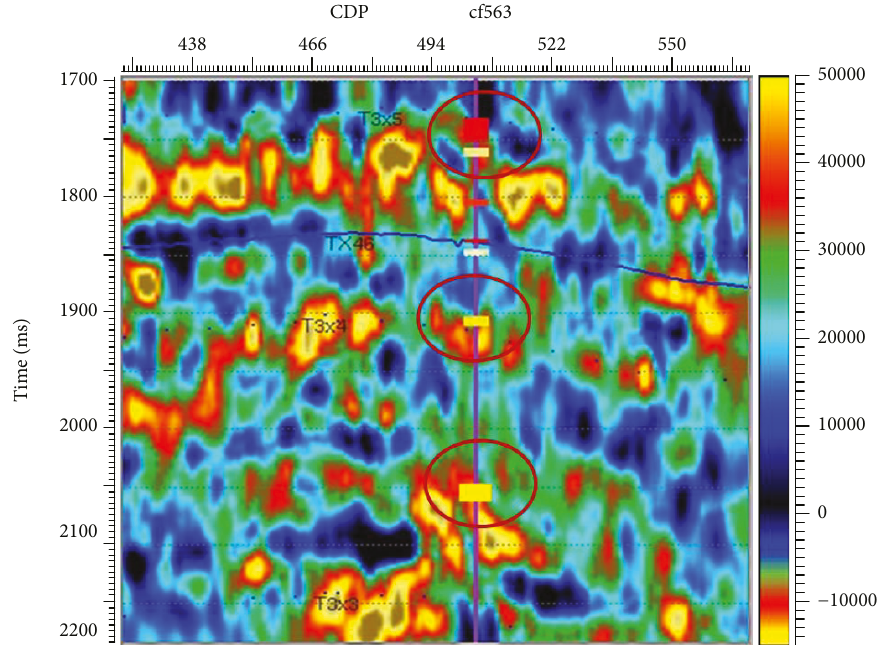
Figure 9: The inversion pro fi le through well cf563. The three domains marked by ellipses are fractured or conventional gas reservoirs. These regions have big value of P-wave dispersion gradient. The inversion results match the well tests in these